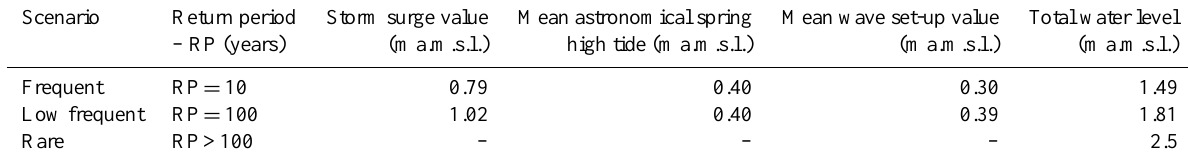
Table 3. Total water level values of each scenario. See comments on RP >100 total water level computation in the text.